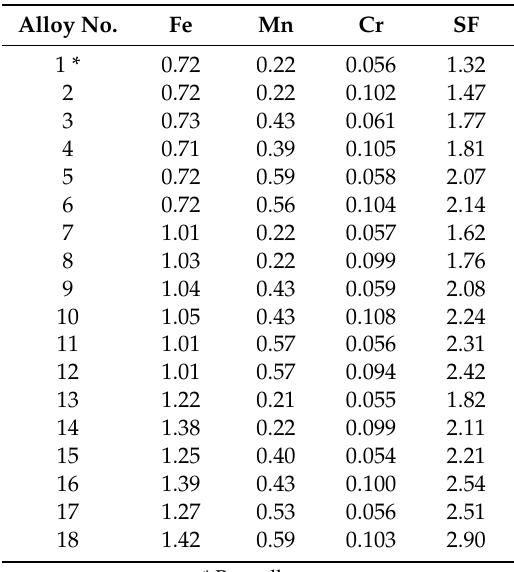
Table 2. Concentration (wt.%) of iron, manganese, and chromium in the experimental alloys. The sludge factors, SF, obtained according to Equation (1), are also